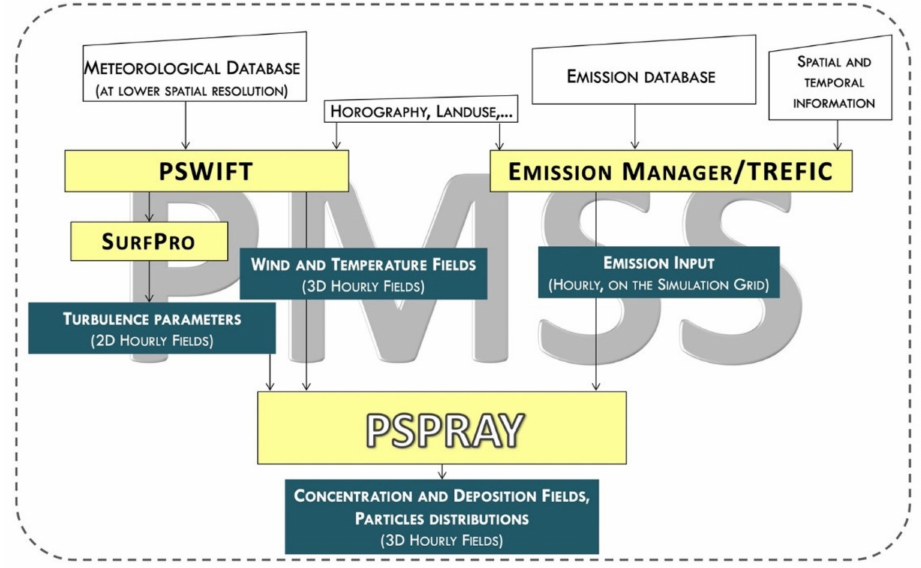
Figure 1. Scheme of the PMSS modelling